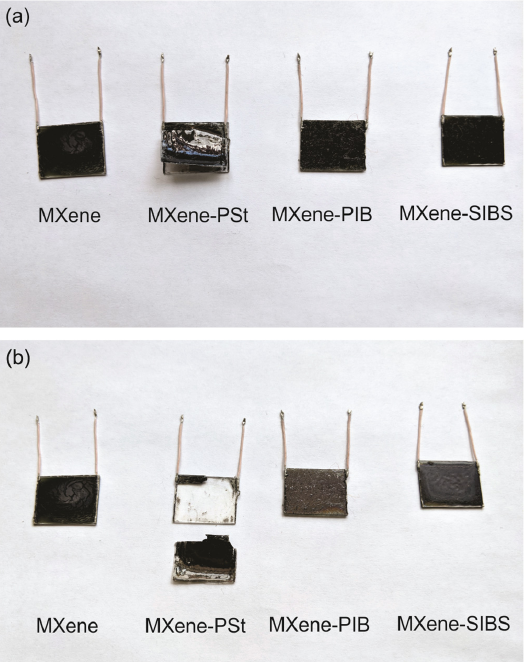
Figure A4. The photos of the samples of uncoated and polymer-coated MXene films on glass sup- ports with contacts for resistivity measurements stored under ambient conditions over 15 days ( a ) and 220 days ( b ).